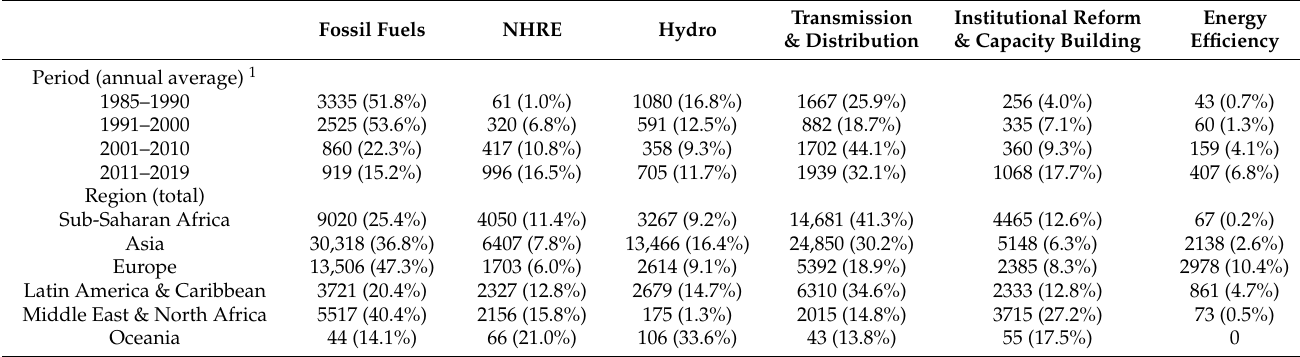
Table 4. Sector-specific energy finance by period and region (unit: 2019 US$